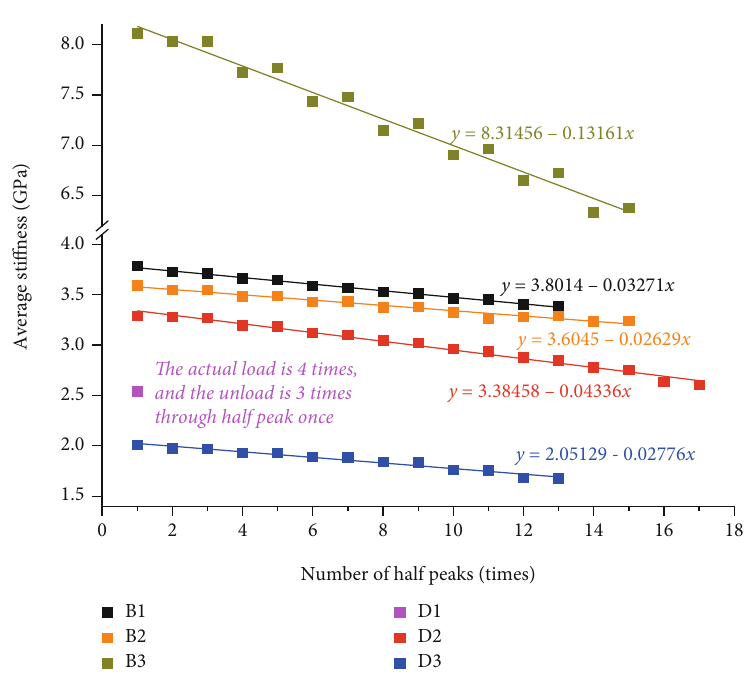
Figure 8: Relationship between average sti ff ness and cycle index of deep coal